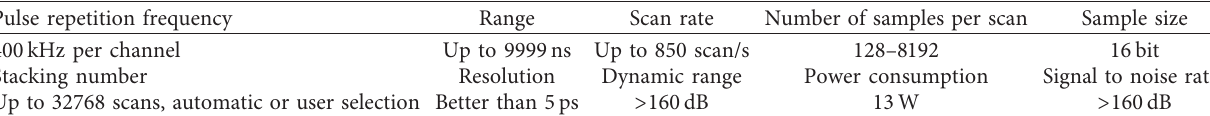
Figure 6: The TR80 antenna. (a) The two antenna and (b) the bonded TR80 antenna. Table 2: Performance parameters of the GPR device [21].